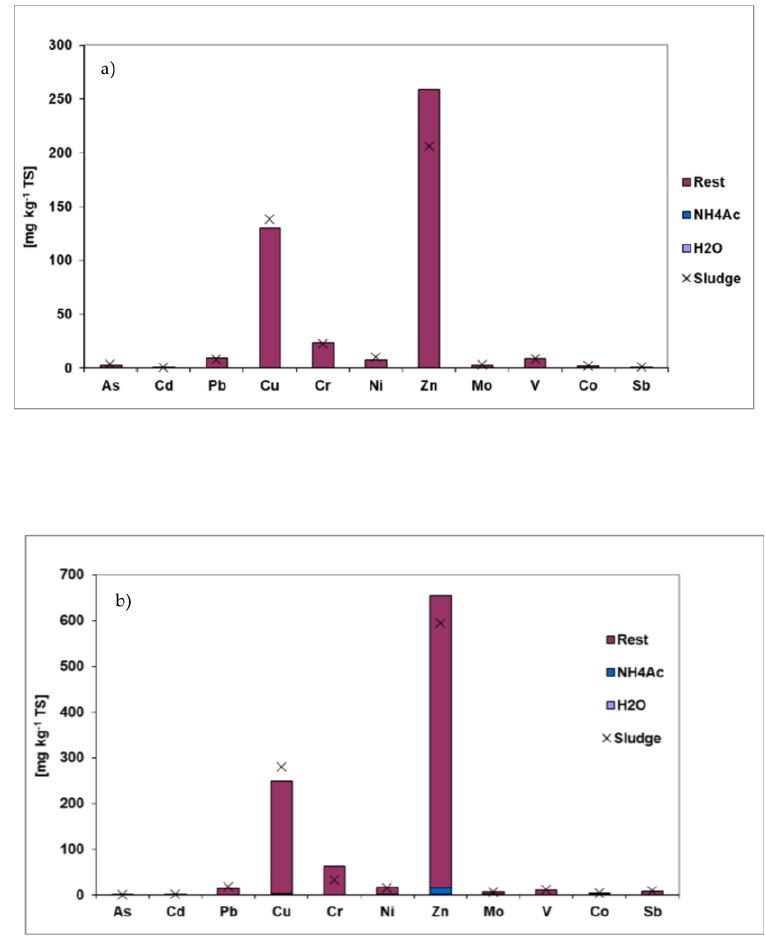
Figure 9. Results of the chemical fractionation of sewage sludge (heavy metals) in mg kg −1 TS. Crosses (X) represent the total concentration of the element in the sewage sludge ( a ) LSS and ( b ) BSS.